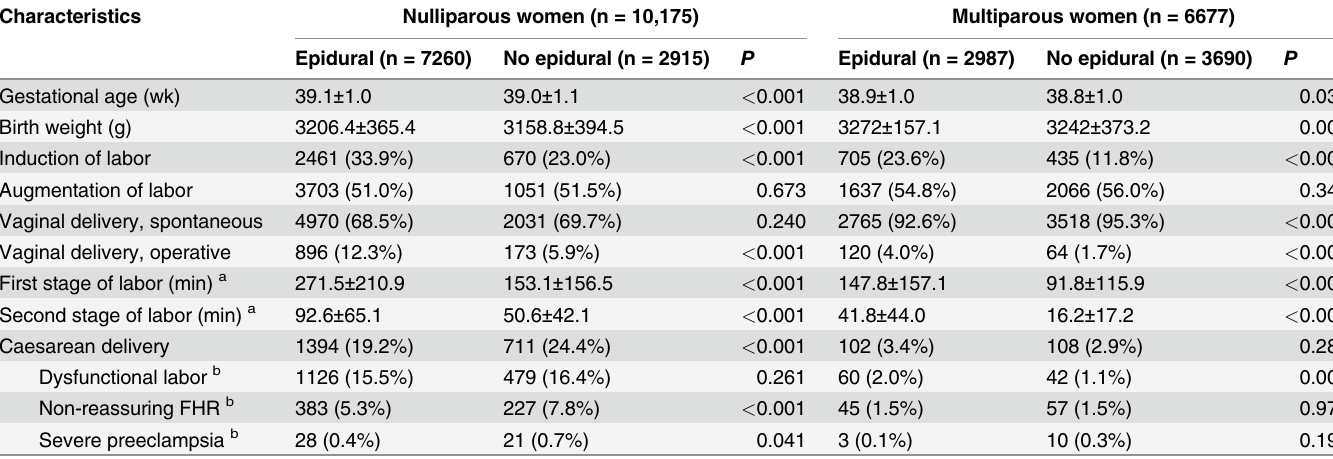
Table 2. Delivery characteristics of the nulliparous and multiparous women with or without the use of epidural analgesia during labor.